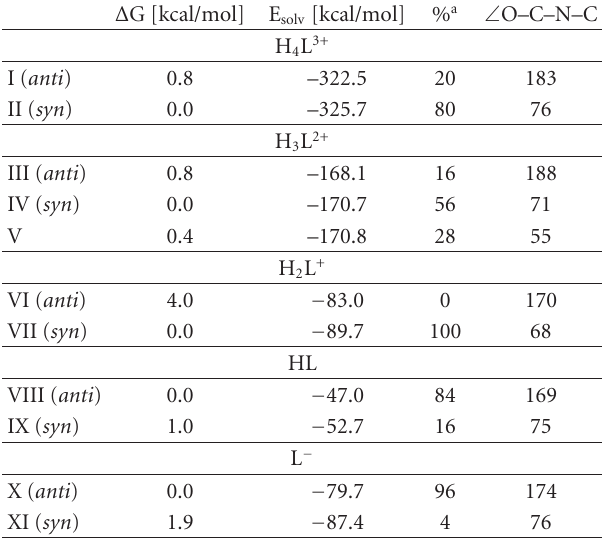
Table 2: Relative Gibbs free energies, Boltzmann factors (in per- cent), energy of solvation, and dihedral angle defining the positions of adenine for the SFG